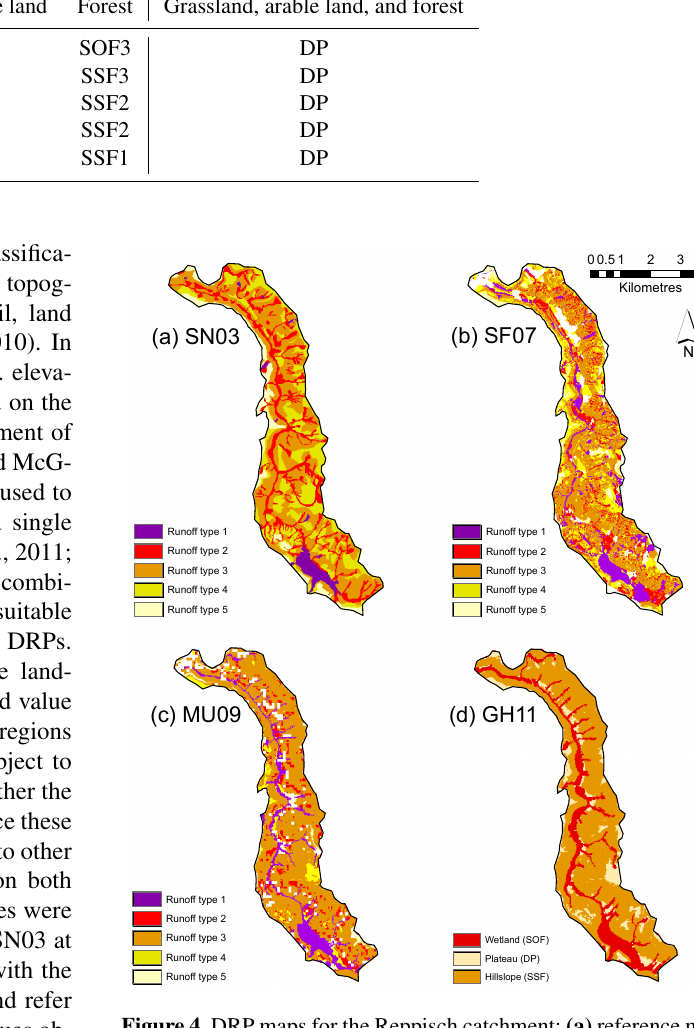
Figure 4. DRP maps for the Reppisch catchment: (a) reference map according to Scherrer and Naef (2003) and automatically derived map according to (b) Schmocker-Fackel et al. (2007), (c) Müller et al. (2009), and (d) Gharari et al.